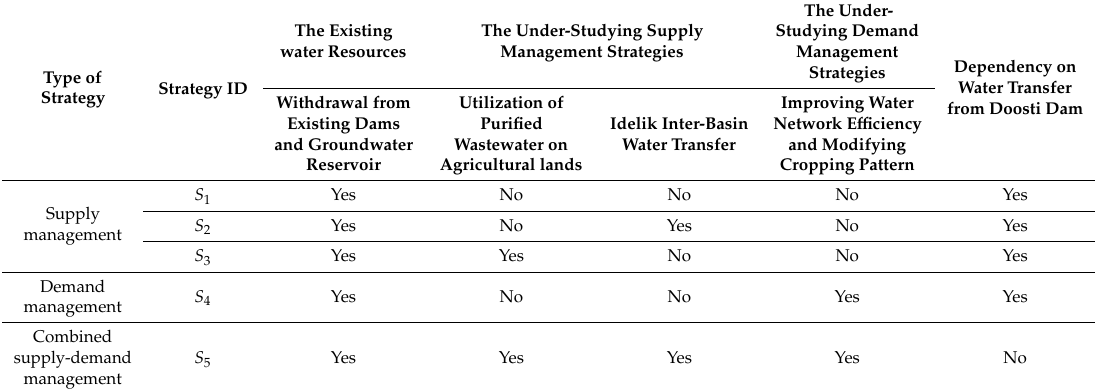
Table 5. The urban water strategies for the Kashafroud watershed by the 2040